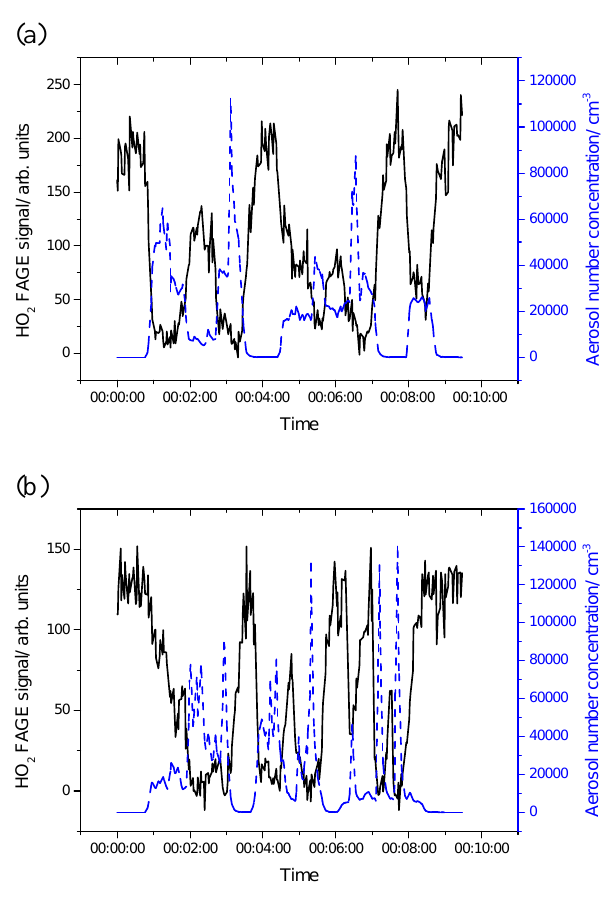
Figure 3. Two examples of the FAGE signal from HO 2 radicals (black line, left axis) together with the dust aerosol number concentration (dashed blue line, right axis), showing anti-correlations. Initial HO 2 concentrations were 1 × 10 9 molecule cm -3 for both plots but for (a) the injector was positioned at 70 cm and the relative humidity was 32 % whereas for (b) the injector was positioned at 60 cm and the relative humidity was 53%.